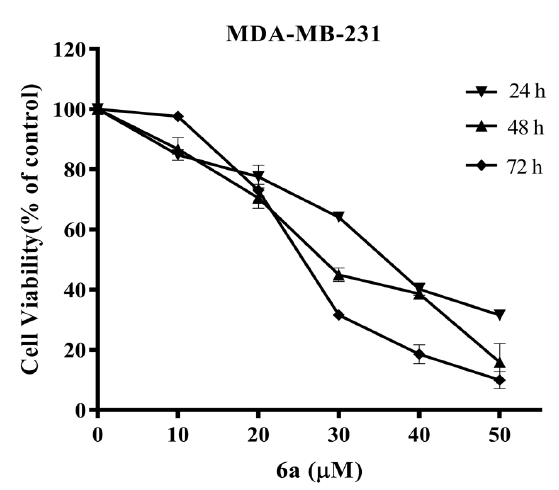
Figure 3. Anti-proliferative activity of 6a on MDA-MB-231 cells.